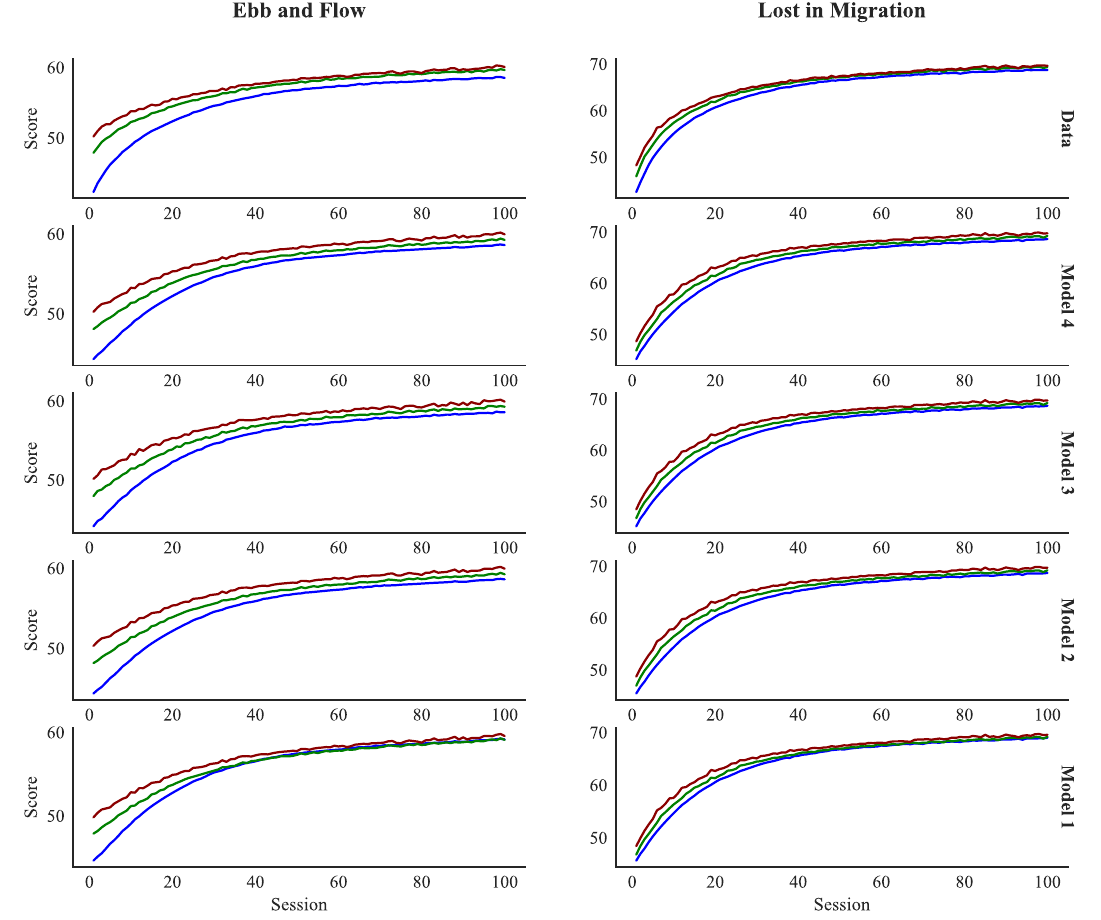
Fig. 5 Observed and predicted aggregate learning curves over sessions for the 1st to 3rd gameplays within each session for Ebb and fl ow and lost in migration. The performance score (vertical axis) is assessed by the number of correct decisions per game